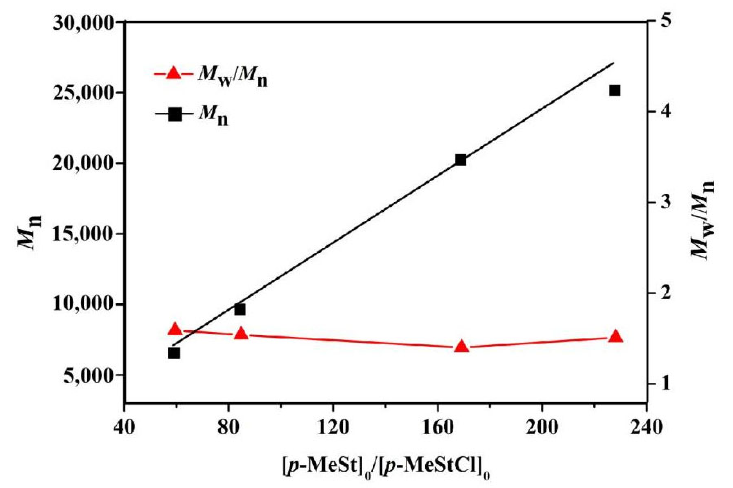
Figure 8. M n and M w /M n values of poly( p -MeSt) obtained in the p -MeStCl/SnCl 4 /DTBP initiating system as a function of the feed ratio of p -MeSt to p -MeStCl. Conditions: [ p -MeSt] 0 = 1.880 mol · L − 1 ;